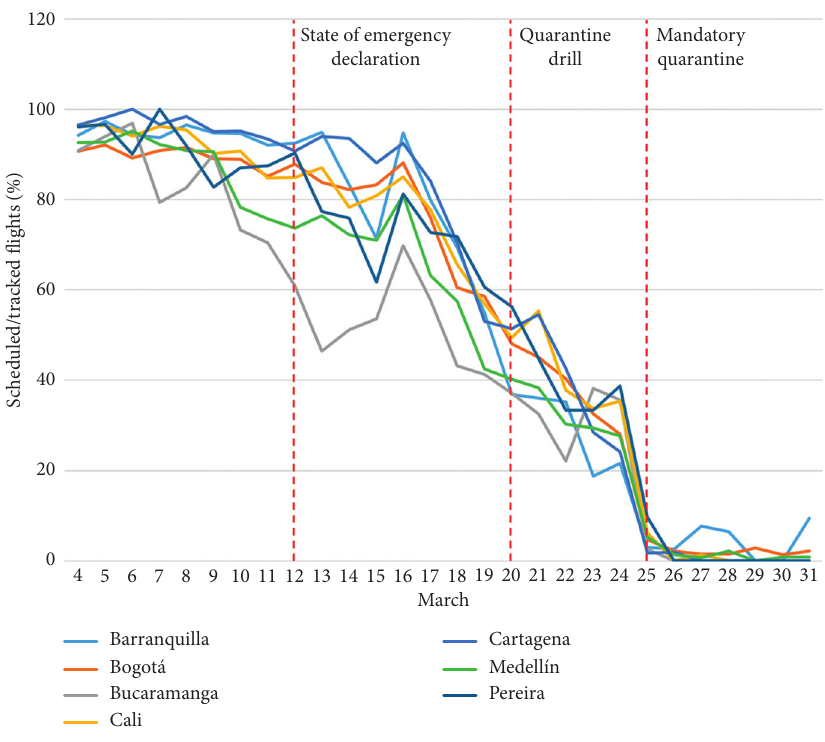
Figure 2: Percentage of completed flights in seven Colombian airports during March